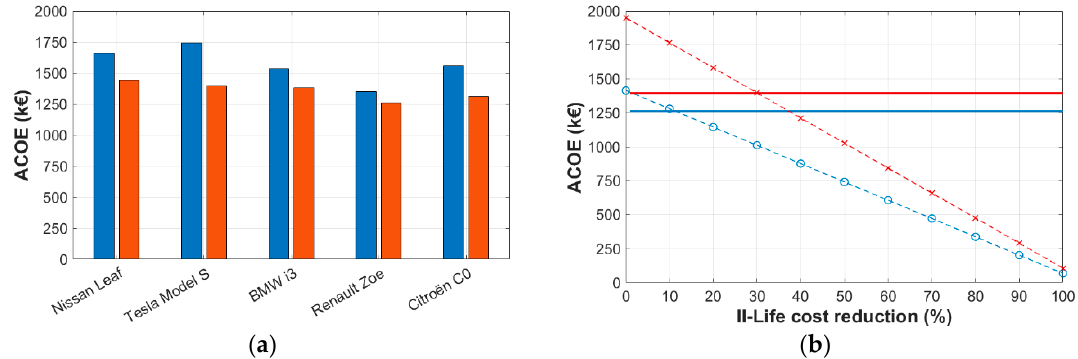
Figure 9. ( a ) Comparison of ACOE for dedicated (blue) and shared (red) ESSs by using different battery packs; ( b ) II-Life ESS cost reduction for shared ESS: best case (red) vs. worst case (blue).